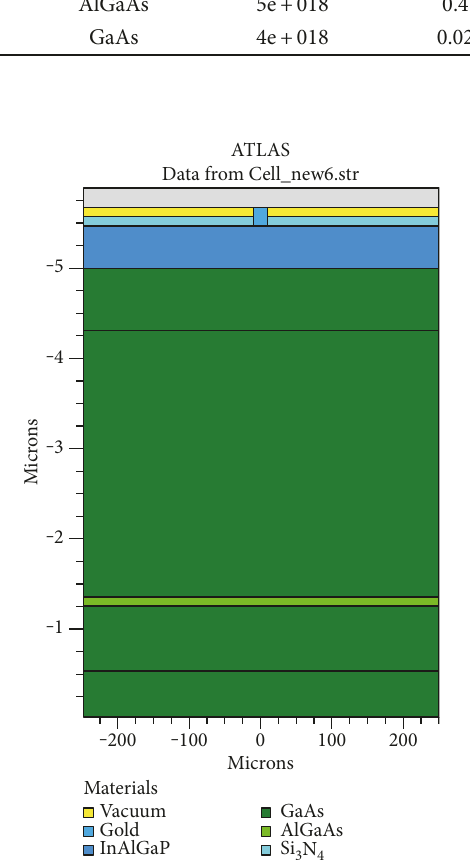
Table 4: Output power improvement.